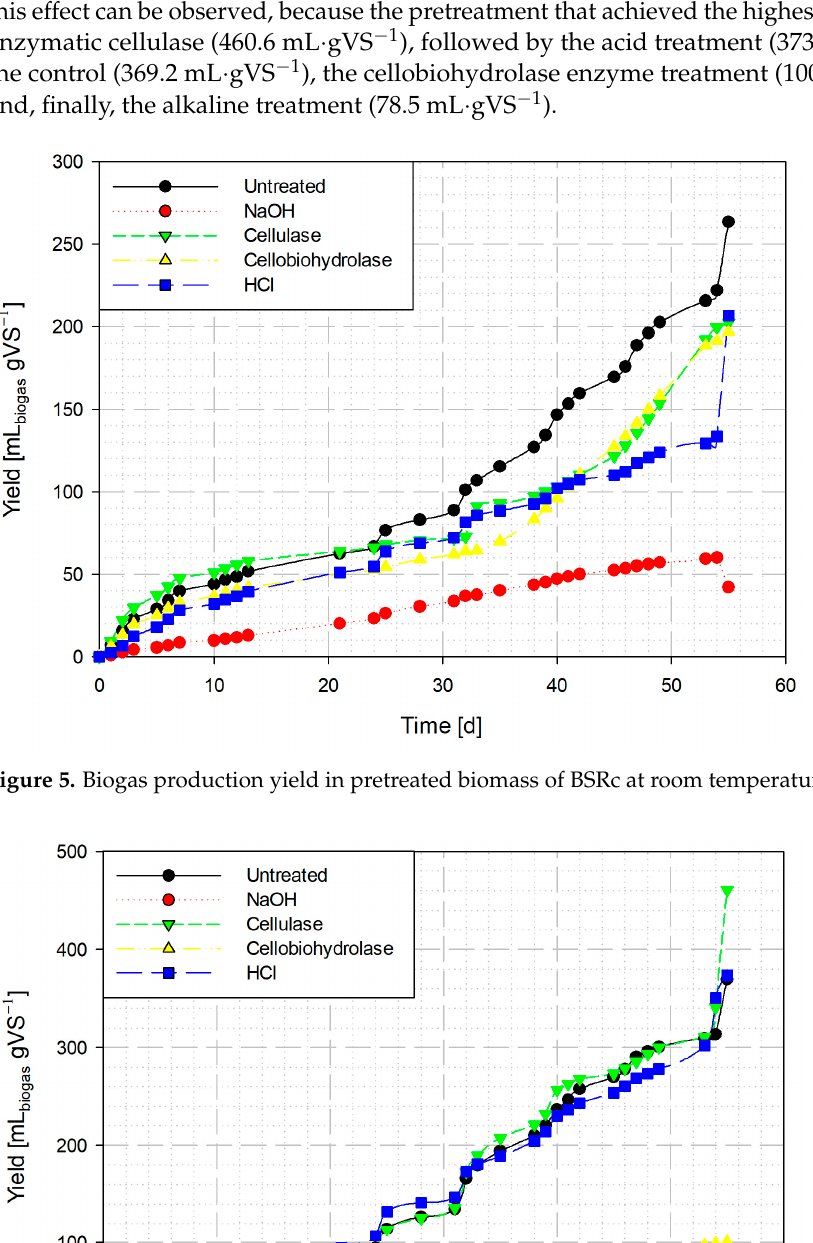
Figure 6. Biogas production yield in pretreated biomass of BSRc at 37 °C.